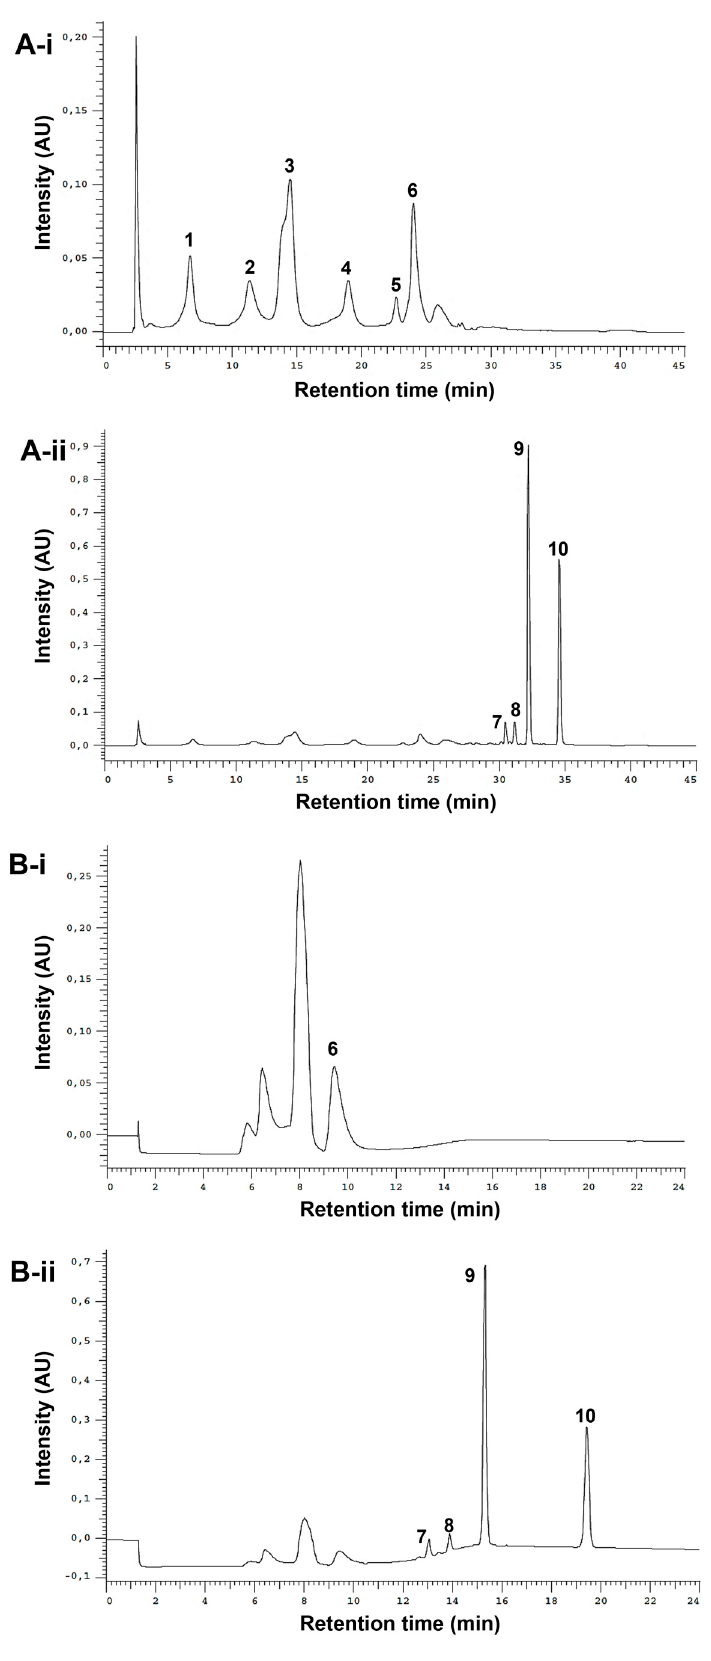
Figure 2. Analytical ( A ) and semi-preparative HPLC chromatograms ( B ) of standard mixture detected at 330 nm (phenols, i ) and 254 nm (alkylamides, ii ). Peak numbering on the chromatograms